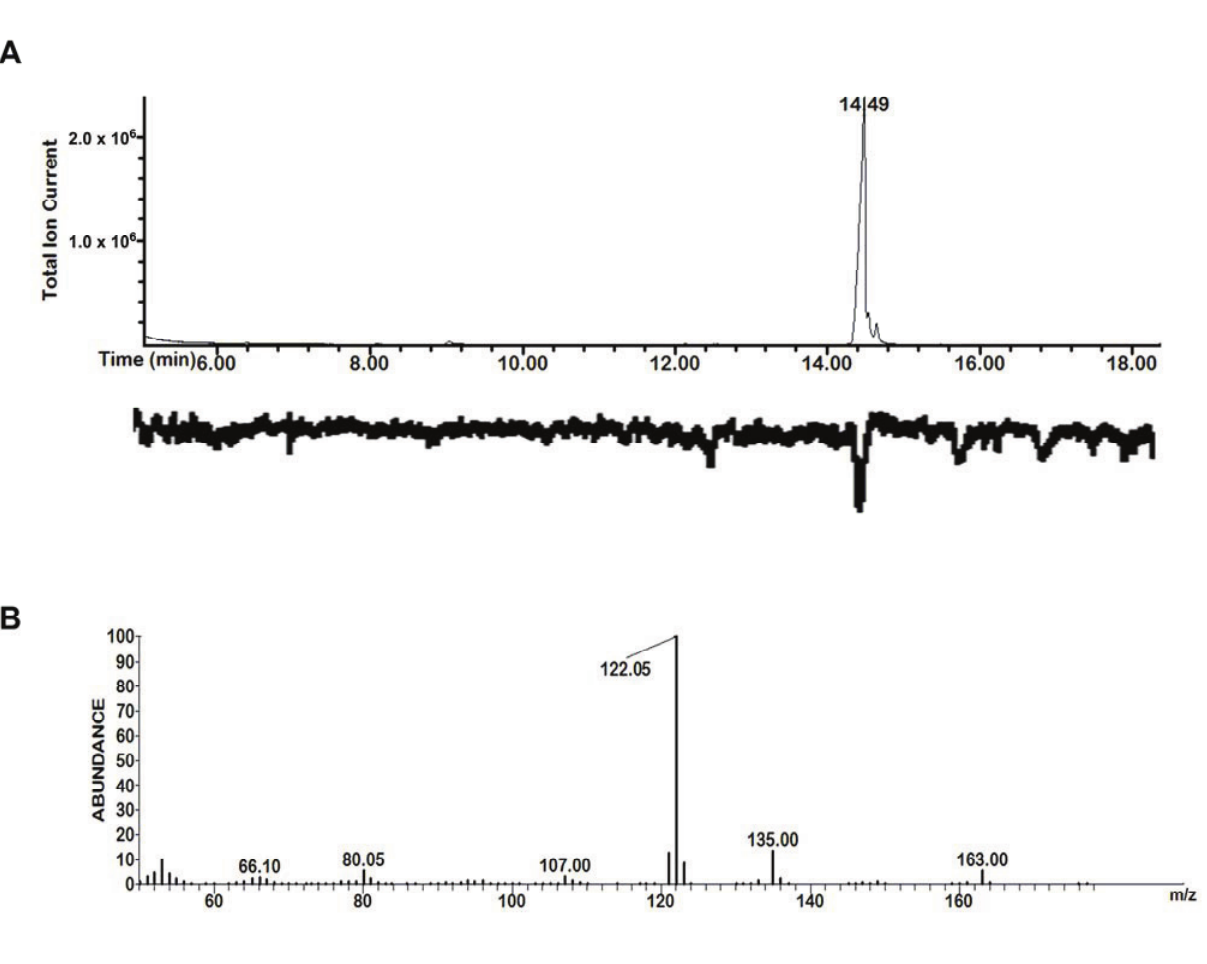
Figure 1. Total ion chromatogram/electroantennogram of 3-(3-methylbutyl)-2,5- dimethylpyrazine ( 6 ) on Catocheilus male wasp ( A , retention time on top of peak) and the extracted mass spectrum ( B , m/z on top of